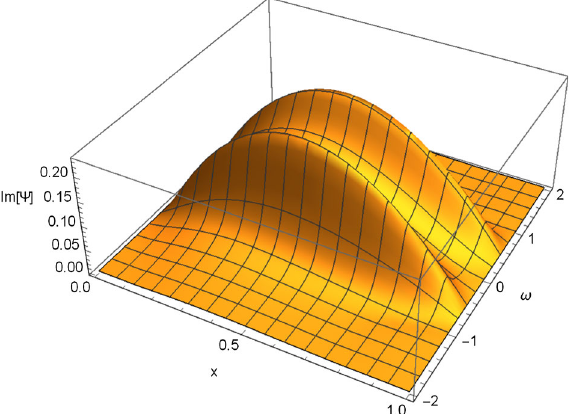
shown as a 2D function of ω and x . Right: The calculated time series of the massless scalar perturbations. The calculations are carried out to generate a total of 50 points in the time series